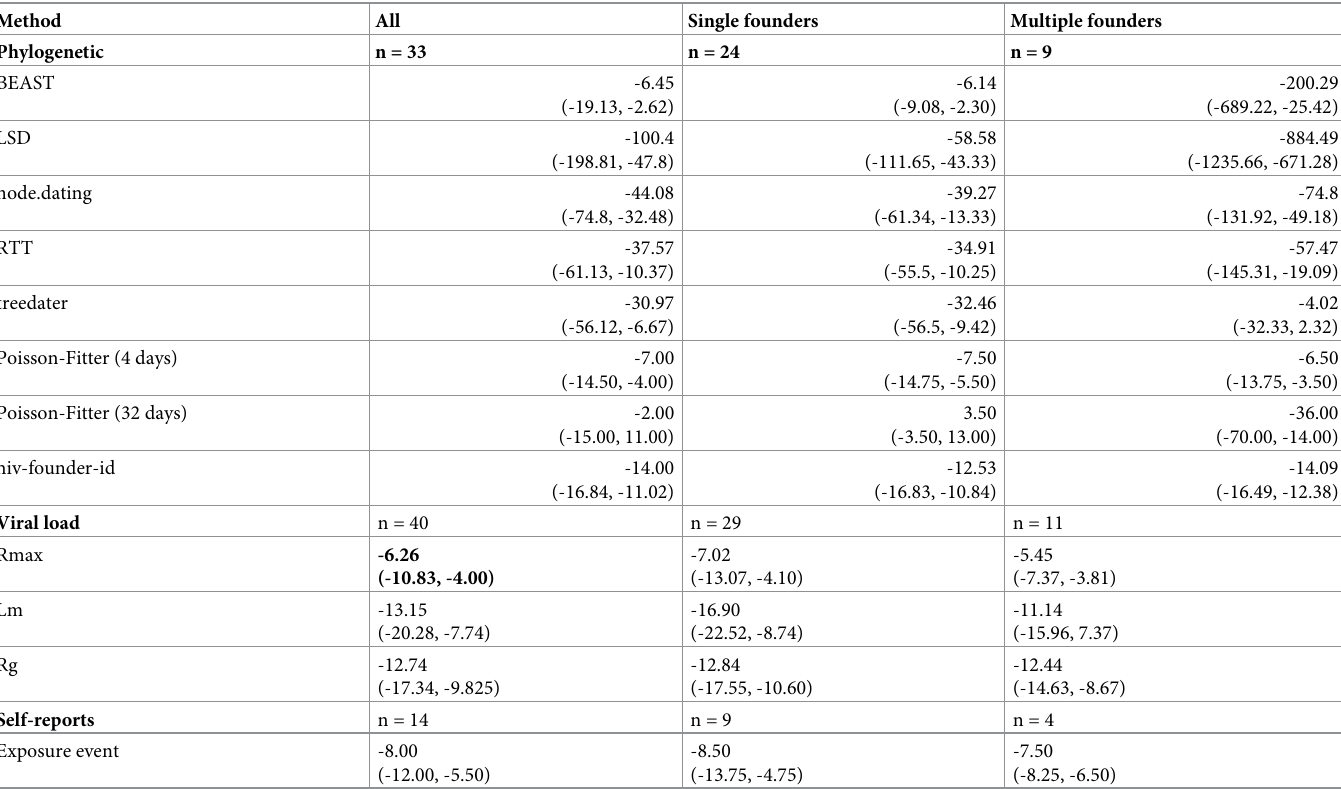
Table 1. Estimated dates of HIV-1 infection for participants with single or multiple HIV-1 founders. Median and inter-quartile range are given for the different meth- ods investigated for all individuals (excluding those without informative temporal signal from the phylogenetic analyses) and separately for participants with single or mul- tiple founders. The first visit from participant 30812 was excluded from Poisson-Fitter estimates (the sequence set corresponded to multiple founders and failed to go through the requirement for homogenous sequences after using the gap procedure). For hiv-founder-id, estimates were based on a subset of 28 participants, including 7 with multi-founder